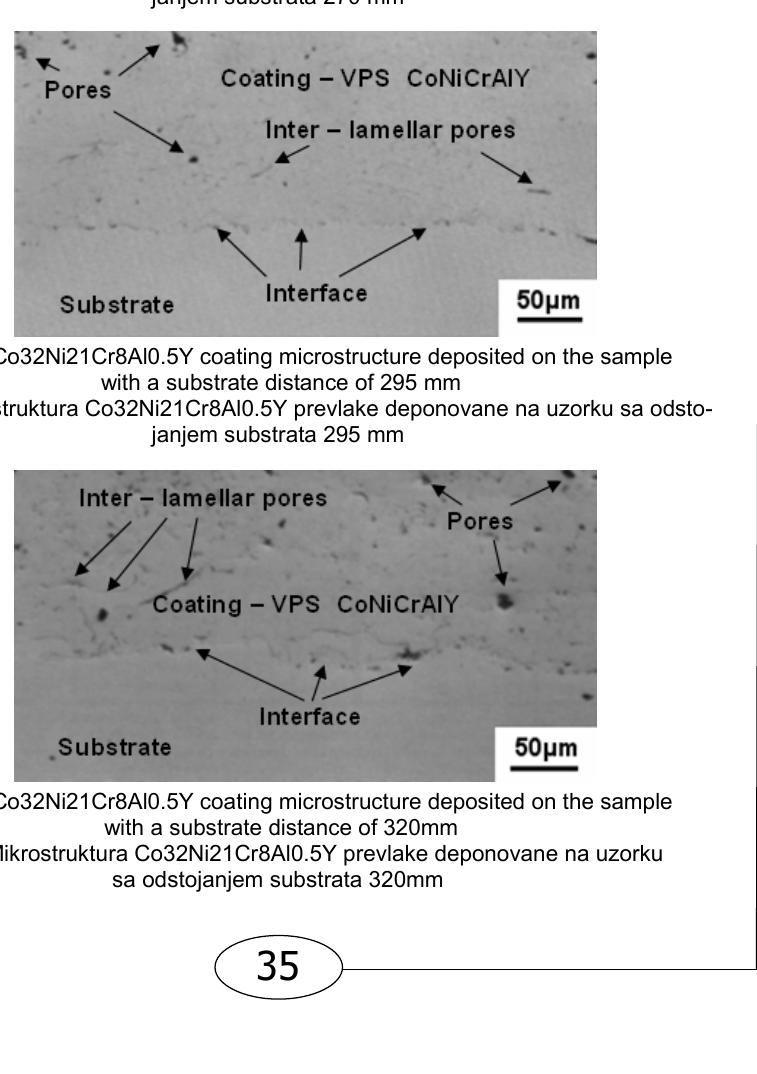
Figure 5 – Co32Ni21Cr8Al0.5Y coating microstructure deposited on the sample with a substrate distance of 270 mm Slika 5 – Mikrostruktura Co32Ni21Cr8Al0.5Y prevlake deponovane na uzorku sa odsto-